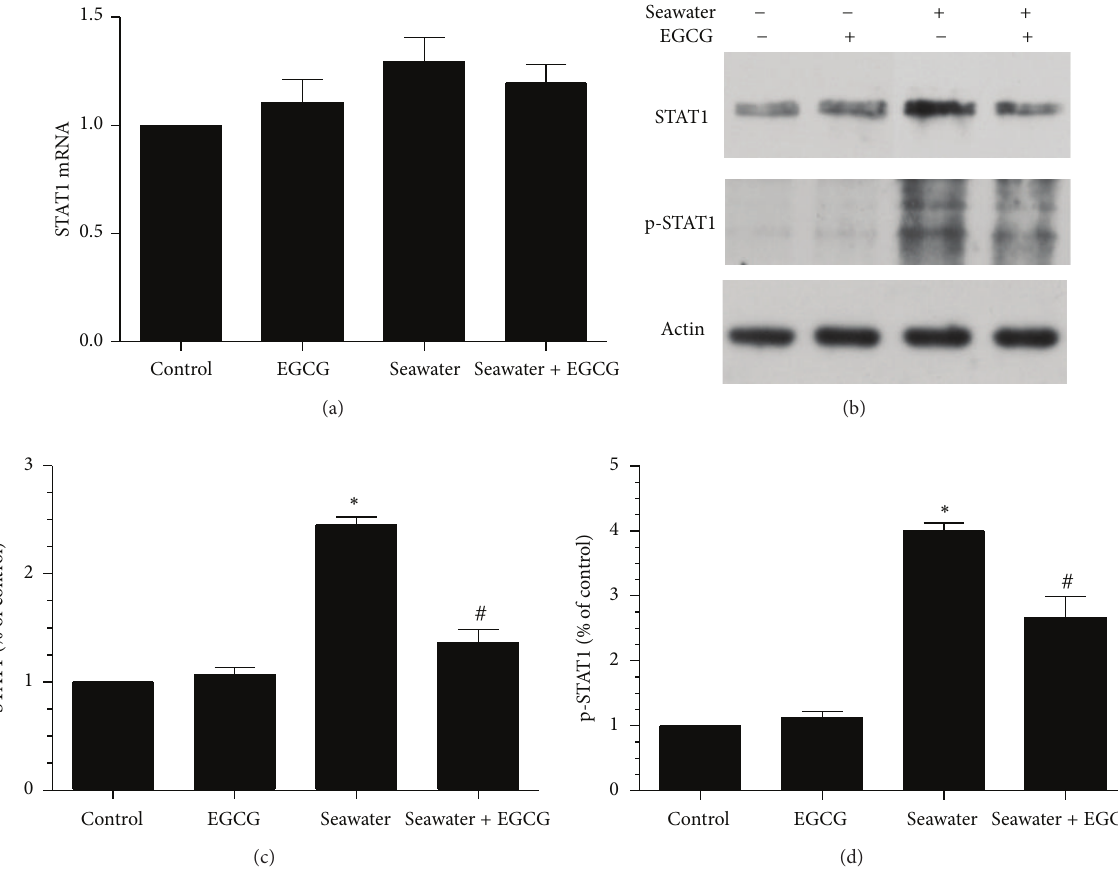
Figure 6: Effects of EGCG pretreatment on the expression of STAT1 and p-STAT1 in rats. (a) mRNA expression of STAT1 in rats; (b) representative western blot for the phosphorylated STAT1 and the total STAT1 protein in different groups. Samples were prepared for western blot analysis using anti-STAT1, anti-p-STAT1, and anti- 𝛽 -actin; (c)-(d) summarized data of the total (c) and the phosphorylated (d) STAT1 protein in different groups. Data represent three independent experiments and are expressed as mean ± SEM; ∗ 𝑃 < 0.05 versus control group; # 𝑃 < 0.05 versus seawater